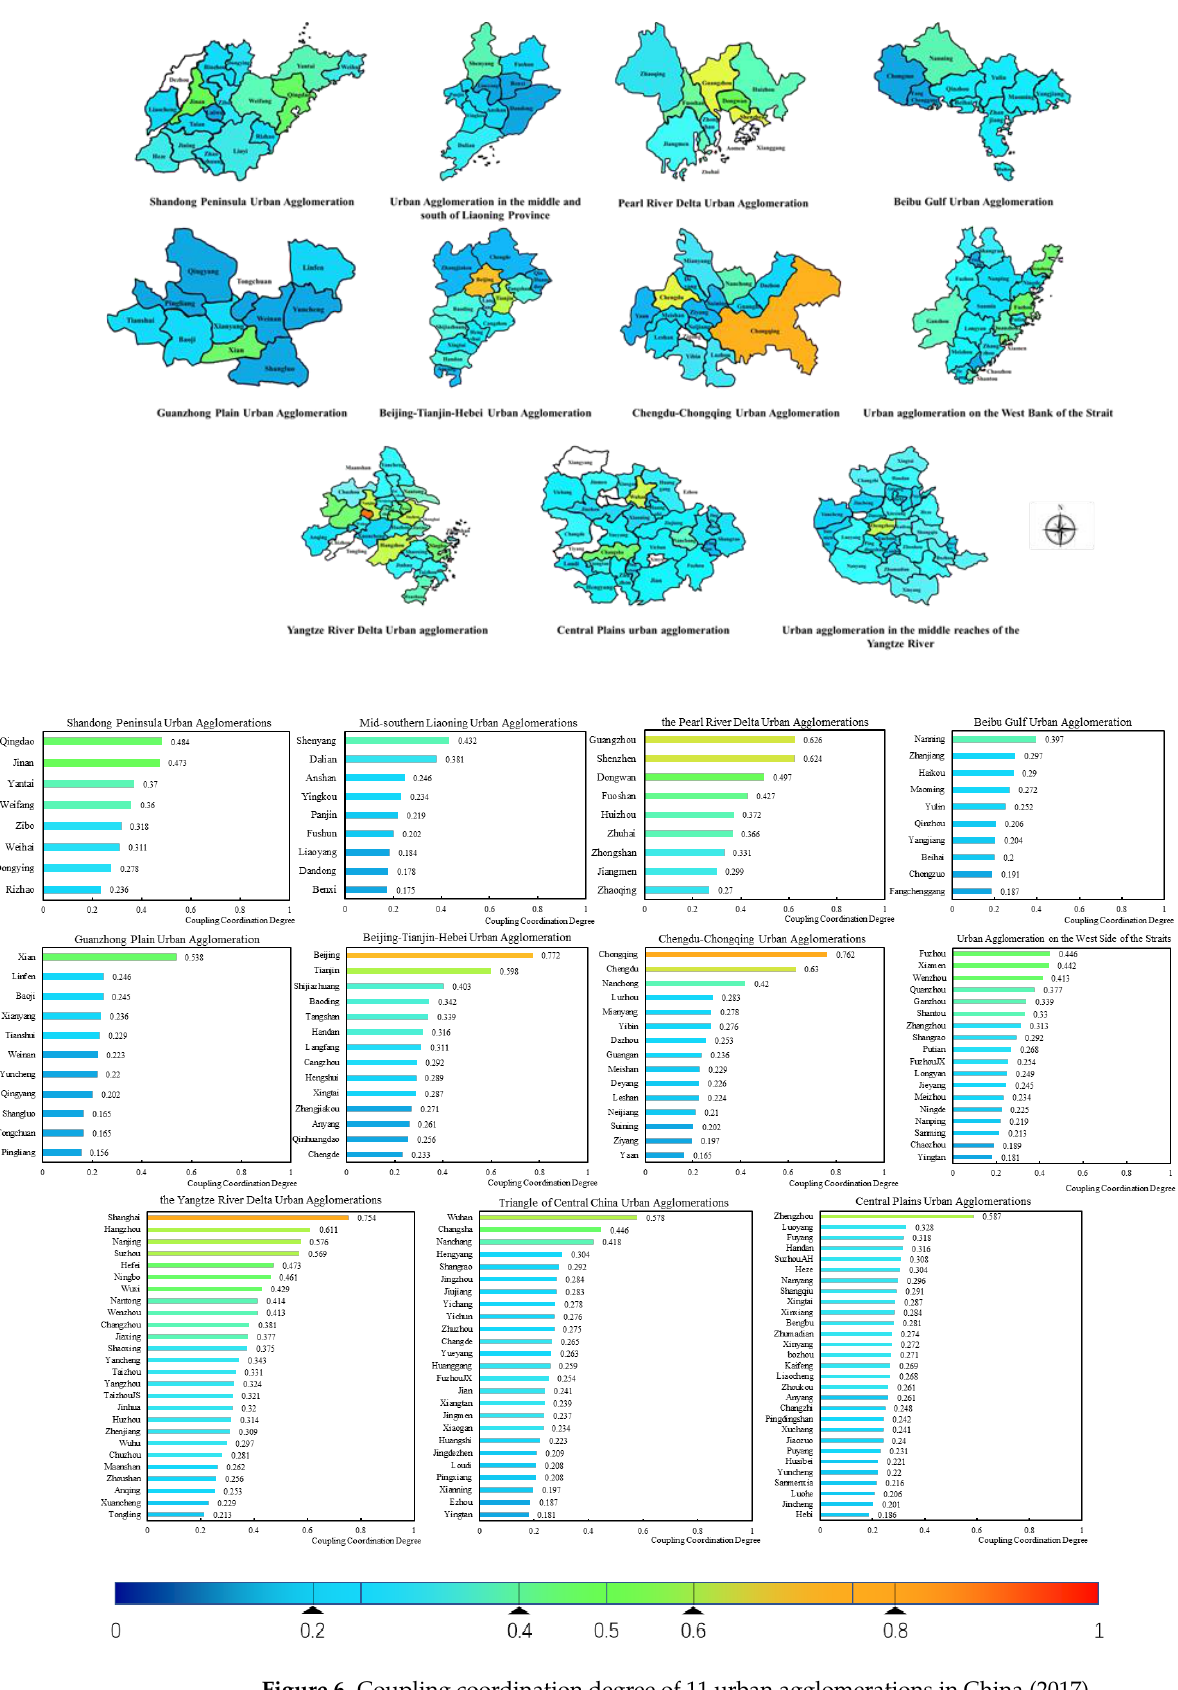
Figure 6. Coupling coordination degree of 11 urban agglomerations in China (2017).